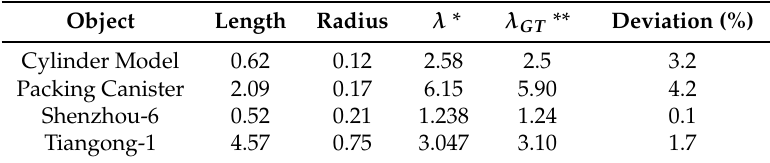
Table 3. Relative size estimation for space objects.